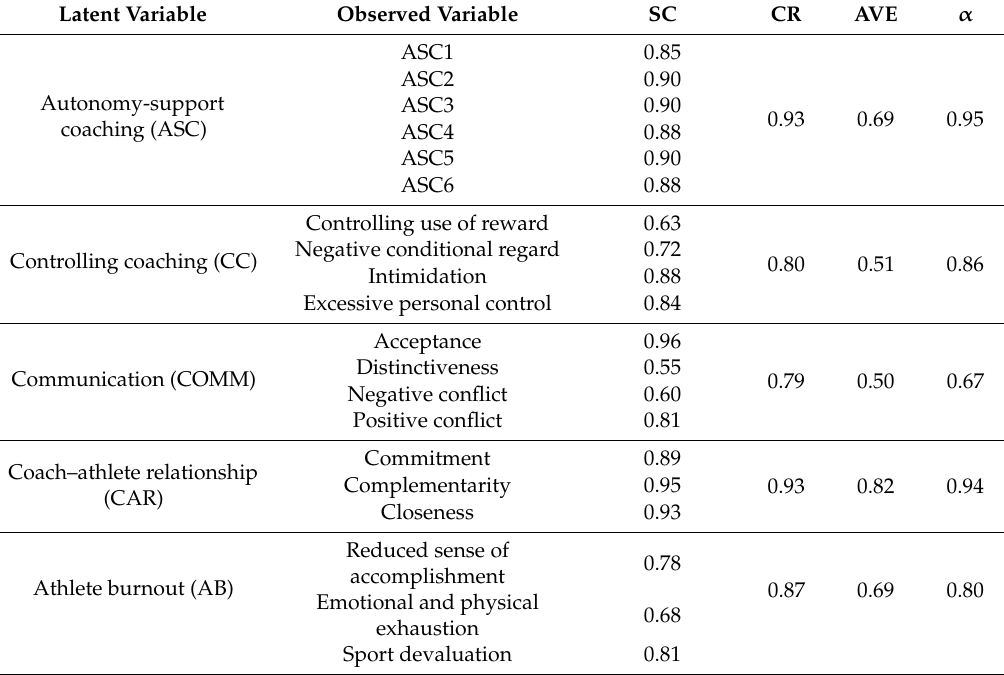
Table 3. Factor loading, Composite reliabilities, AVE, and Cronbach’s alpha in the Measurement